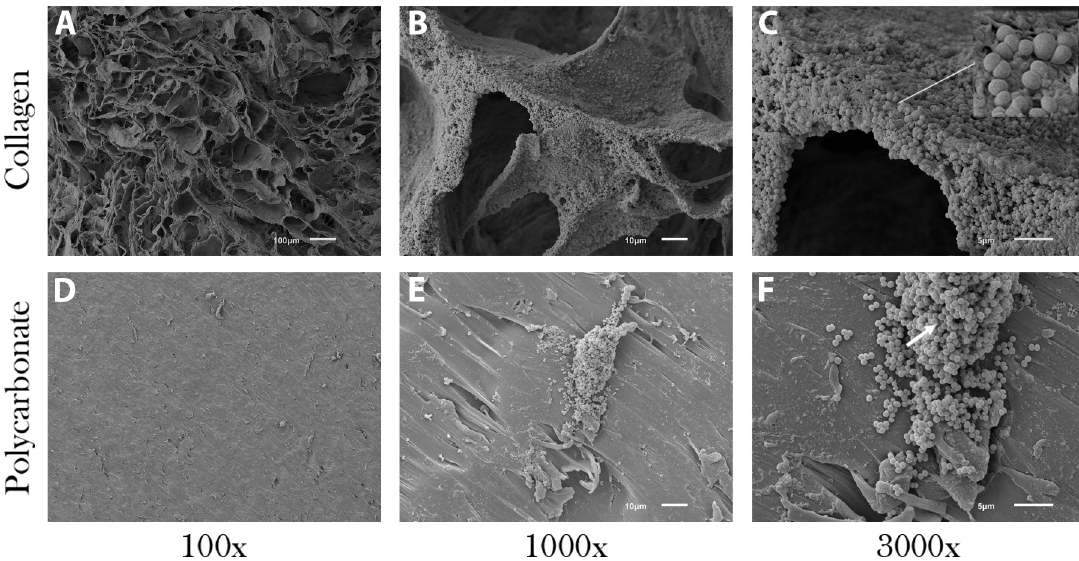
Fig 4. Representative SEM images of MRSA USA 400 biofilm on both material types. (A-C) Surface of collagen with biofilm growth. Biofilm structure resulted in uniform coverage, but did not appear to plume as other staphylococcal isolates did. Rather, MRSA USA 400 displayed sheet-like growth on collagen. (D-F) Surface of a polycarbonate coupon that had sparse coverage, although where biofilm did form, it plumed to an estimated 30 cell layers thick. Arrow (panel F) indicates a biofilm plume.